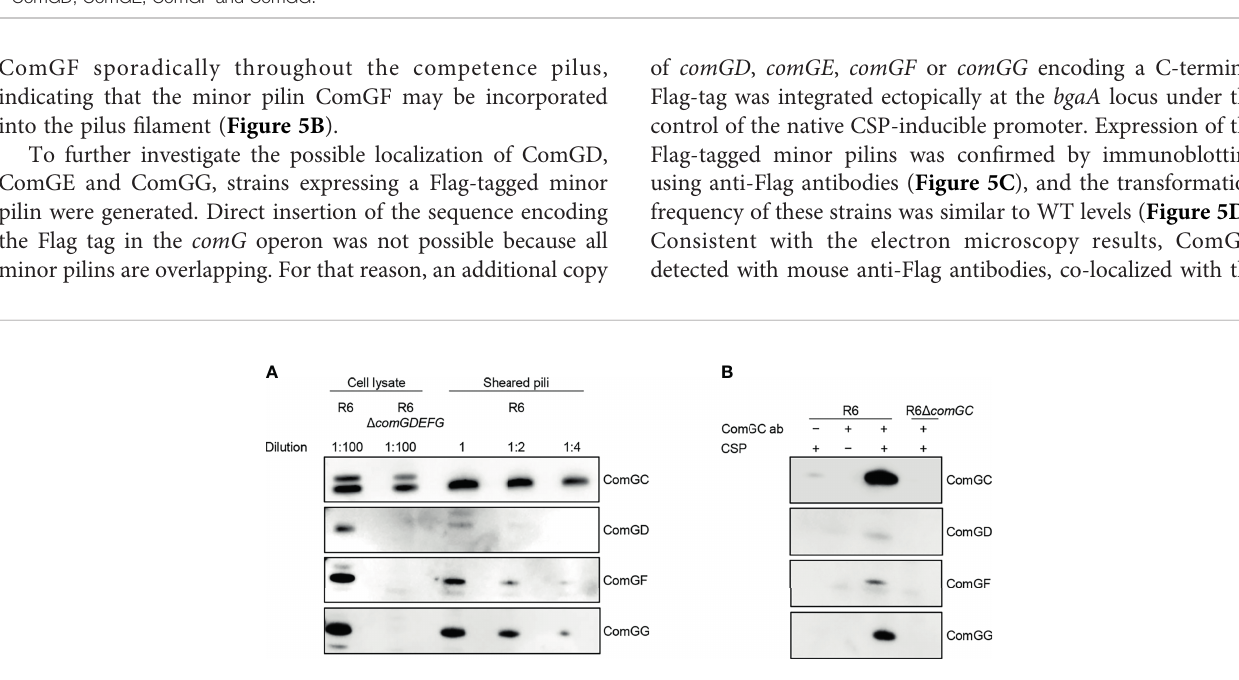
FIGURE 3 | Soluble domains of pneumococcal minor pilins interact directly. (A) Untagged (ComGD soluble , ComGE soluble or ComGG soluble ) or GST-tagged C-terminal, soluble domains of the pneumococcal pilins (GST-C, GST-D, GST-E, GST-F or GST-G) were expressed individually in E. coli. Pellets expressing untagged protein were mixed with pellets expressing GST-tagged pilins, lysed in a high-pressure cell disrupter and the supernatants were applied to GSH Sepharose Fast Flow af fi nity resin. E. coli expressing only GST was included as a negative control. Elution fractions were separated by SDS-PAGE and the upper gel part was stained with Coomassie brilliant blue and the lower gel part was immunoblotted with antisera speci fi c for ComGD, ComGE or ComGG. (B, C) Co-immunoprecipitation (IP) of minor pilins co-expressed in E. coli . The bacterial pellet from cells co-expressing the soluble domains of ComGD, ComGE, ComGF and ComGG was lysed, centrifuged and the supernatant was immunoprecipitated using anti-ComGG antibodies coupled to Protein G Dynabeads ™ (+). Uncoupled beads (-) were included as a negative control. IP samples were separated by SDS-PAGE followed by (B) Coomassie brilliant blue staining and (C) immunoblotting with antibodies against ComGD, ComGE, ComGF and ComGG.